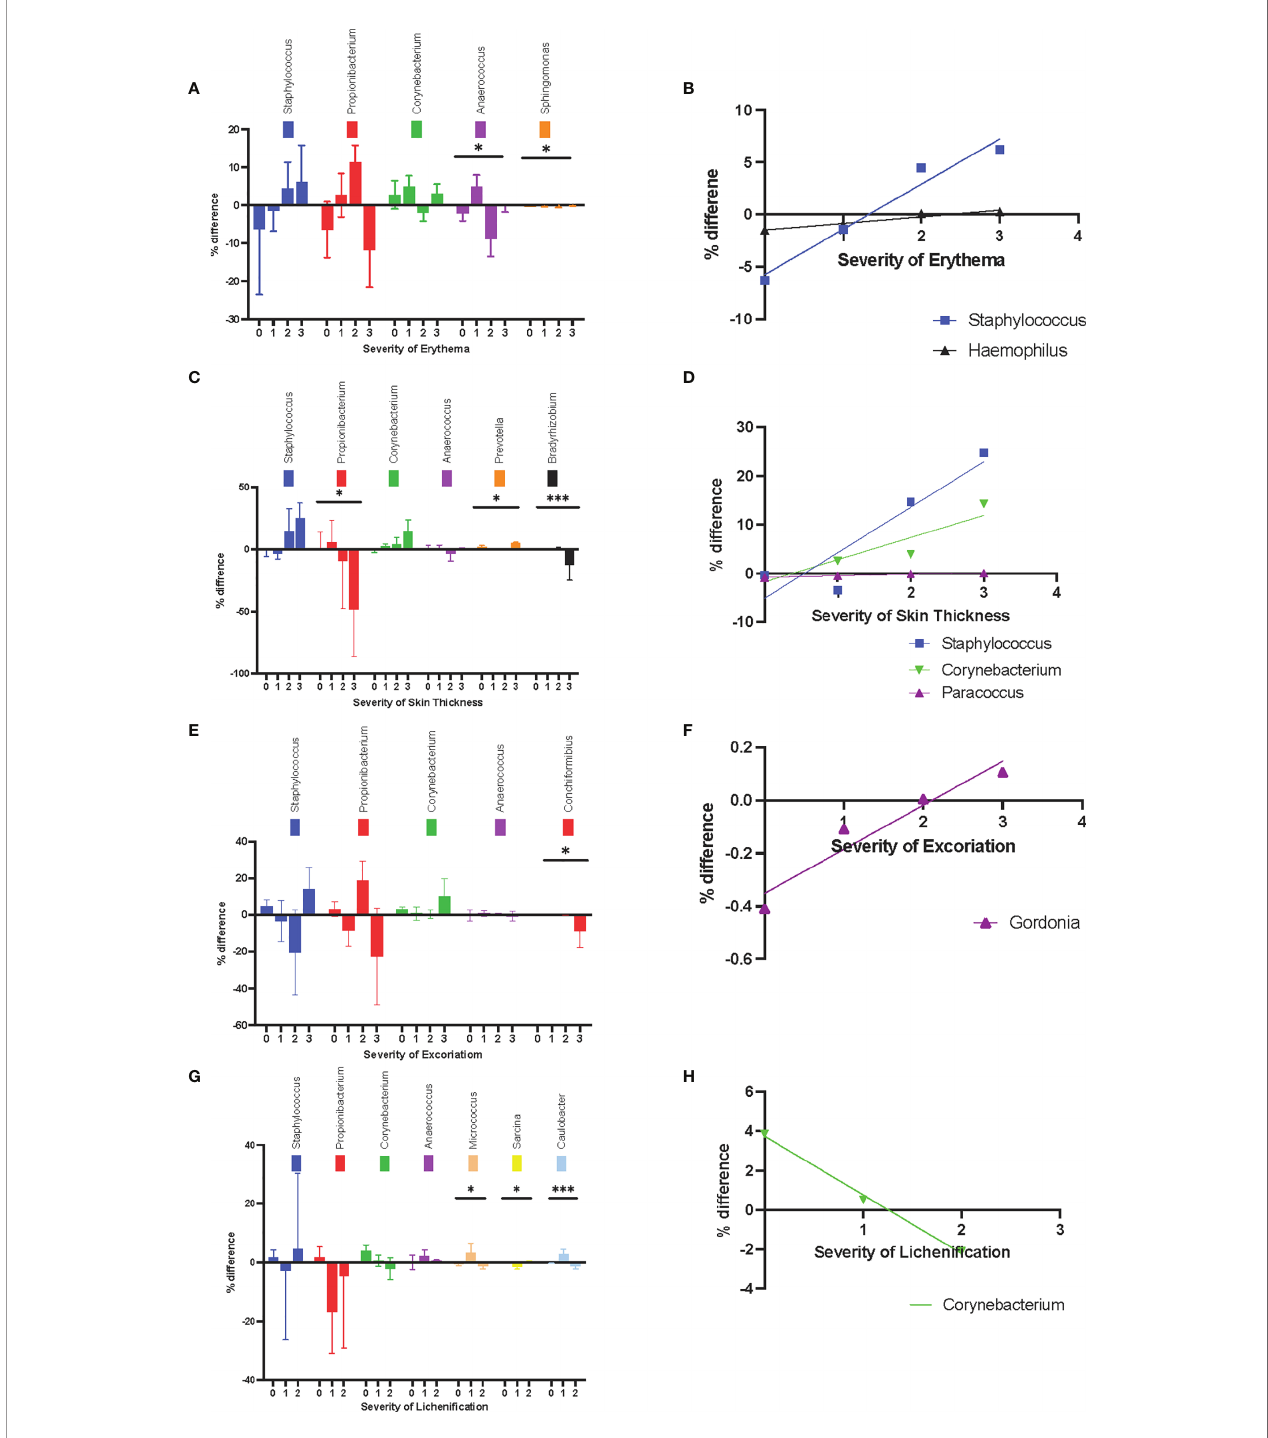
FIGURE 4 | Sign-associated changes in skin microbiota composition at the genus level. (A) The changes in relative abundance at different erythema levels. (B) The increase in relative abundance of Staphylococcus spp. and Haemophilus spp. in lesional skin were positively corelated with erythema. (C) The changes in relative abundance at different skin thickness levels. (D) The increase in relative abundance of Paracoccus sp. in lesional skin was positively correlated with thicker skin. (E) The changes in relative abundance at different level of excoriation. (F) The increase in relative abundance of Gordonia spp. in the lesional skin was positively correlated with excoriation level. (G) changes in relative abundance at different levels of licheni fi cation (H) The increase in relative abundance of Corynebacterium in lesional skin was negatively correlated with licheni fi cation. *P ≤ 0.05; ***P ≤